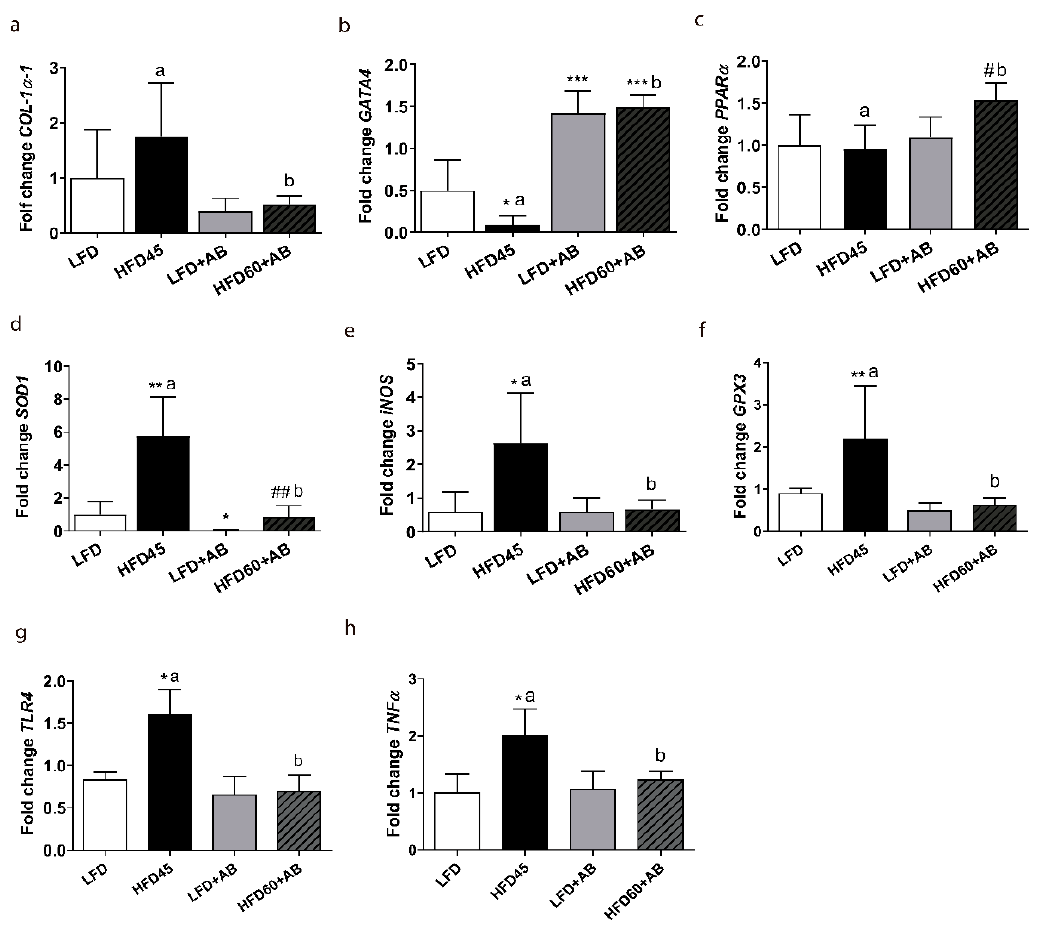
Figure 5. Gene expression analysis of fibrosis, oxidative stress, and inflammatory markers in the livers of LDLR -/- mice after 12 weeks of nutritional intervention with AB extract. ( a ) COL1 α 1 . ( b ) GATA4 . ( c ) PPAR α . ( d ) SOD1 . ( e ) iNOS . ( f ) GPX3 . ( g ) TLR4. ( h ) TNF α . All data are shown as the means ± SD ( n = 5). * p ≤ 0.05/** p ≤ 0.01/*** p ≤ 0.001 vs. LFD; # p ≤ 0.05/## p ≤ 0.01 vs. LFD+AB. Different letters indicate significant differences among the HFD groups ( p ≤ 0.05).